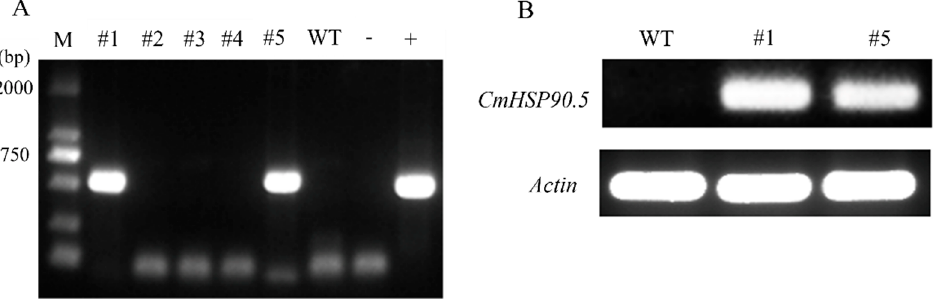
Figure 5. Validation of transgenic plants. ( A ) PCR analysis of genomic DNA extracted from kanamycin-resistant lines. ( B ) Transcription levels of CmHSP90.5 in Col-0 and transgenic lines determined by RT-PCR. AtActin2 was used as the reference gene.